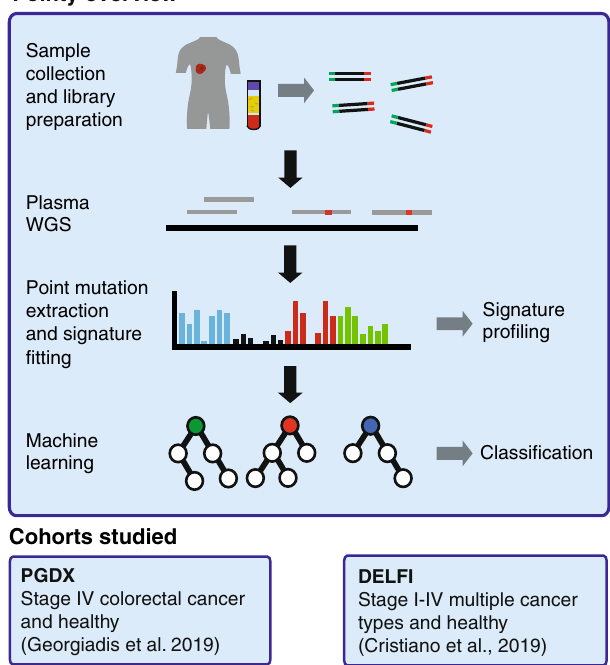
Fig. 1 | Study outline and characterization of Pointy data. cfDNA libraries were generated from plasma samples from patients with cancer and healthy individuals from two independent cohorts. Whole-genome sequencing (WGS) was performed to0.3 – 1.5×coverage(SupplementaryData1).Mutationalsignatureswereextracted fromthesedata,enablingsignaturepro fi lingandsampleclassi fi cation( “ Methods ” ), tested in two independent